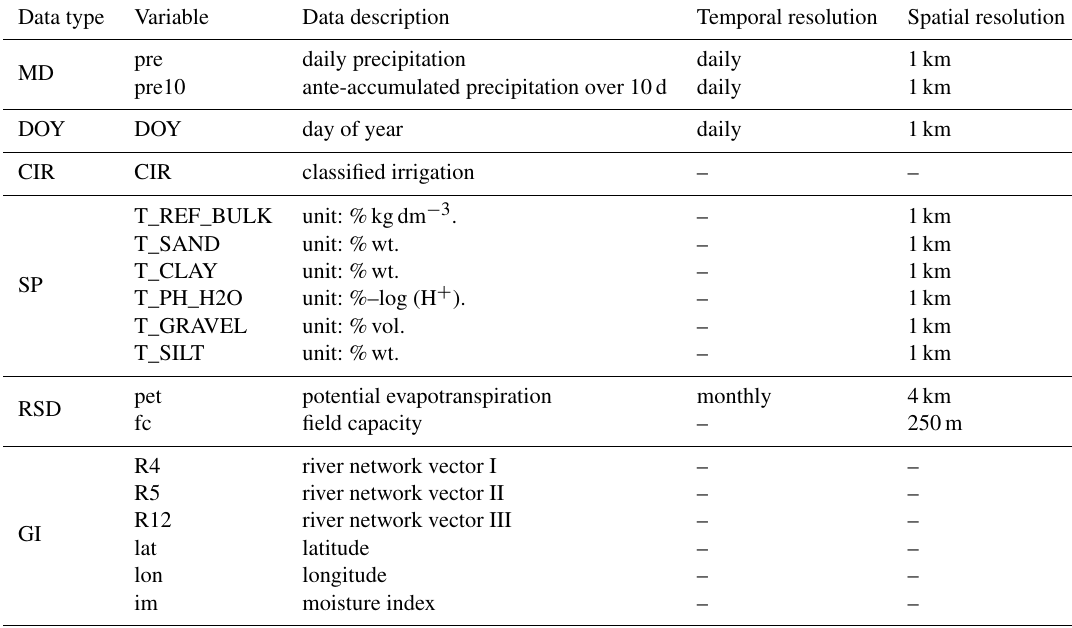
Table 1. Environmental factors used in the study, including meteorological data (MD), day of year (DOY), classified irrigation (CIR), soil properties (SP), remote sensing data (RSD) and geographical information (GI).